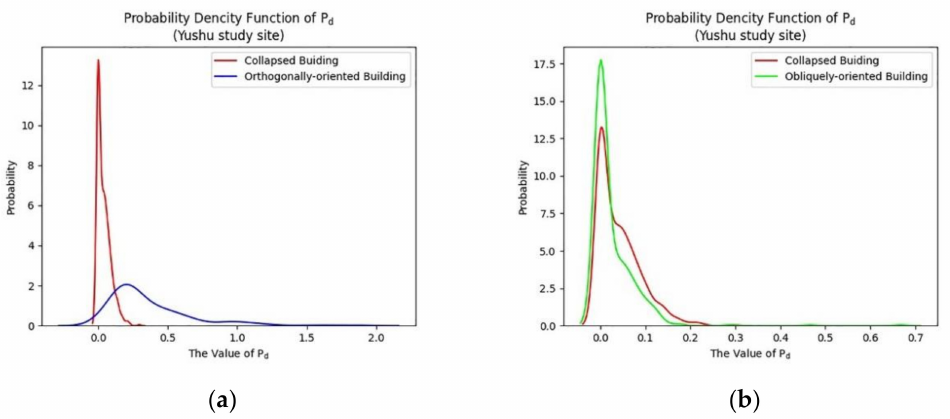
Figure 16. The pdfs of the double-bounce scattering component of the Yamaguchi decomposition ( P d ) feature: ( a ) pdfs of collapsed buildings and orthogonally-oriented buildings; ( b ) pdfs of collapsed buildings and obliquely-oriented